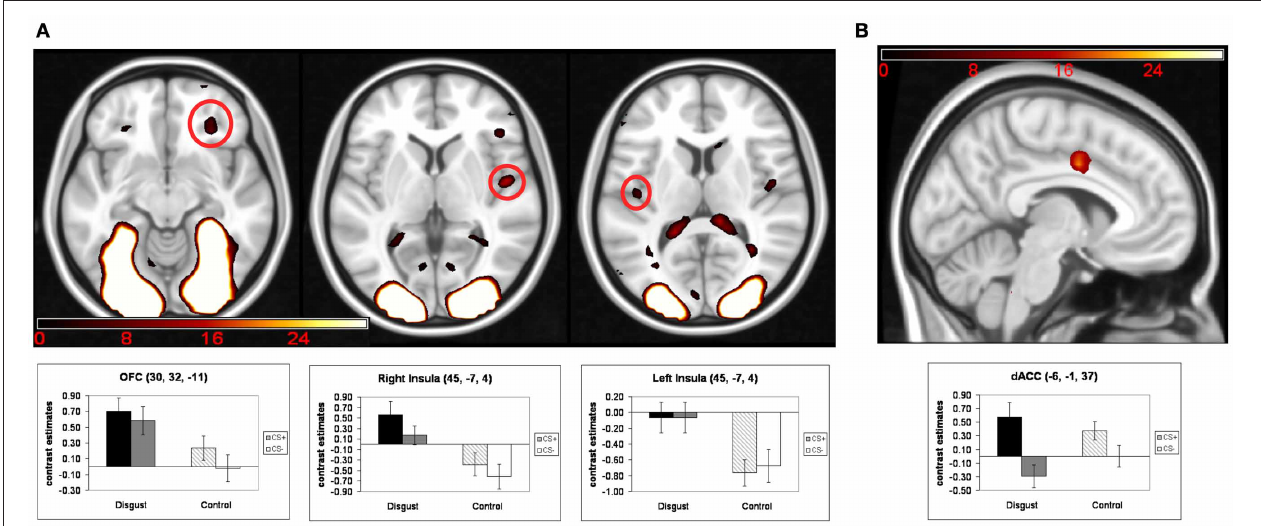
FIGURE 2 | Results of the ANOVA of conditioned responses: (A) main effects of the factor “CS-emotion”; (B) main effects of the factor “reward learning”. Mean contrast estimates (and standard errors of the